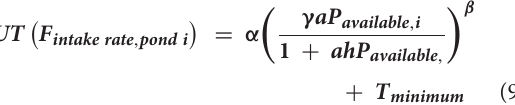
necessary for the foraging wading bird to spend at least